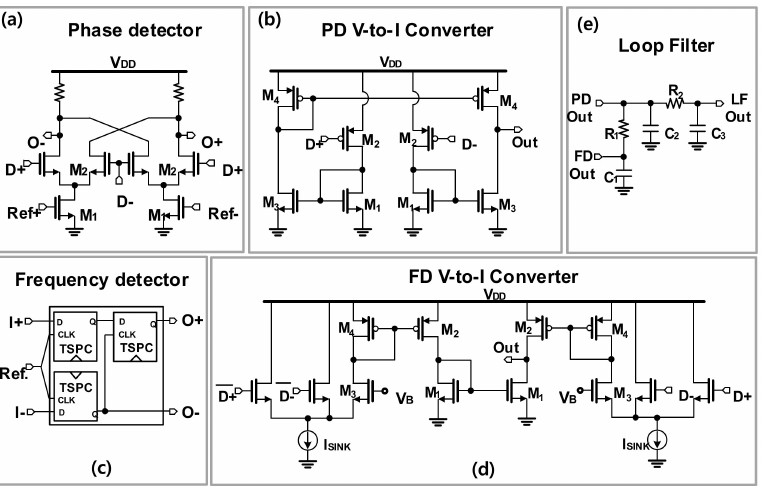
Figure 11. Schematics of ( a ) the phase detector; ( b ) the V-to-I converter for the PD; ( c ) frequency detector; ( d ) V-to-I converter for the FD, and ( e ) the loop